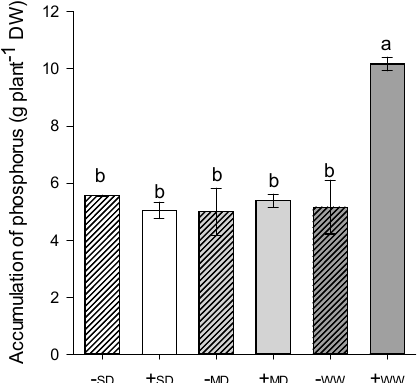
Figure 4. Accumulation of phosphorus of H. serratifolius plants subjected to different water regimes in the presence and absence of arbuscular mycorrhizal fungi. -SD: severe water deficit without AMF; +SD: severe water deficit with AMF; -MD: moderate water deficit without AMF; +MD: moderate water deficit with AMF; -WW: well-watered without AMF; +WW: well-watered with AMF. The means of variables with the same letter are not statistically different by Tukey’s test ≤ 5%.